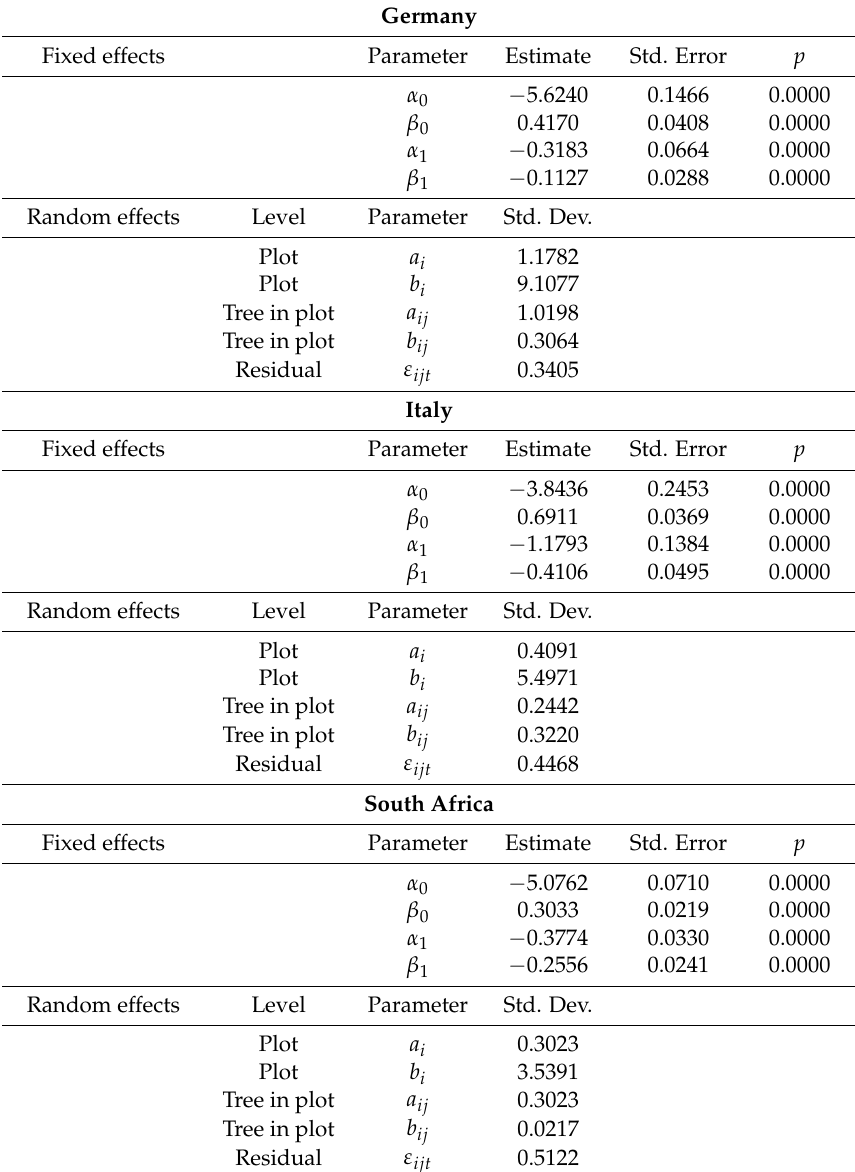
Table A2. Model parameters for the linear mixed effect model Equation (8) displaying the change of size-growth relation (Figure 5). Parameter estimates for each experiment’s fixed effects with standard errors (Std. Error) and significances ( p ) and the standard deviation (Std. Dev.) of random